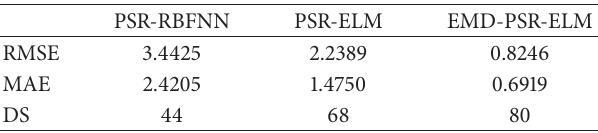
Table 2: Performance of the three forecasting methods for interna- tional uranium resource